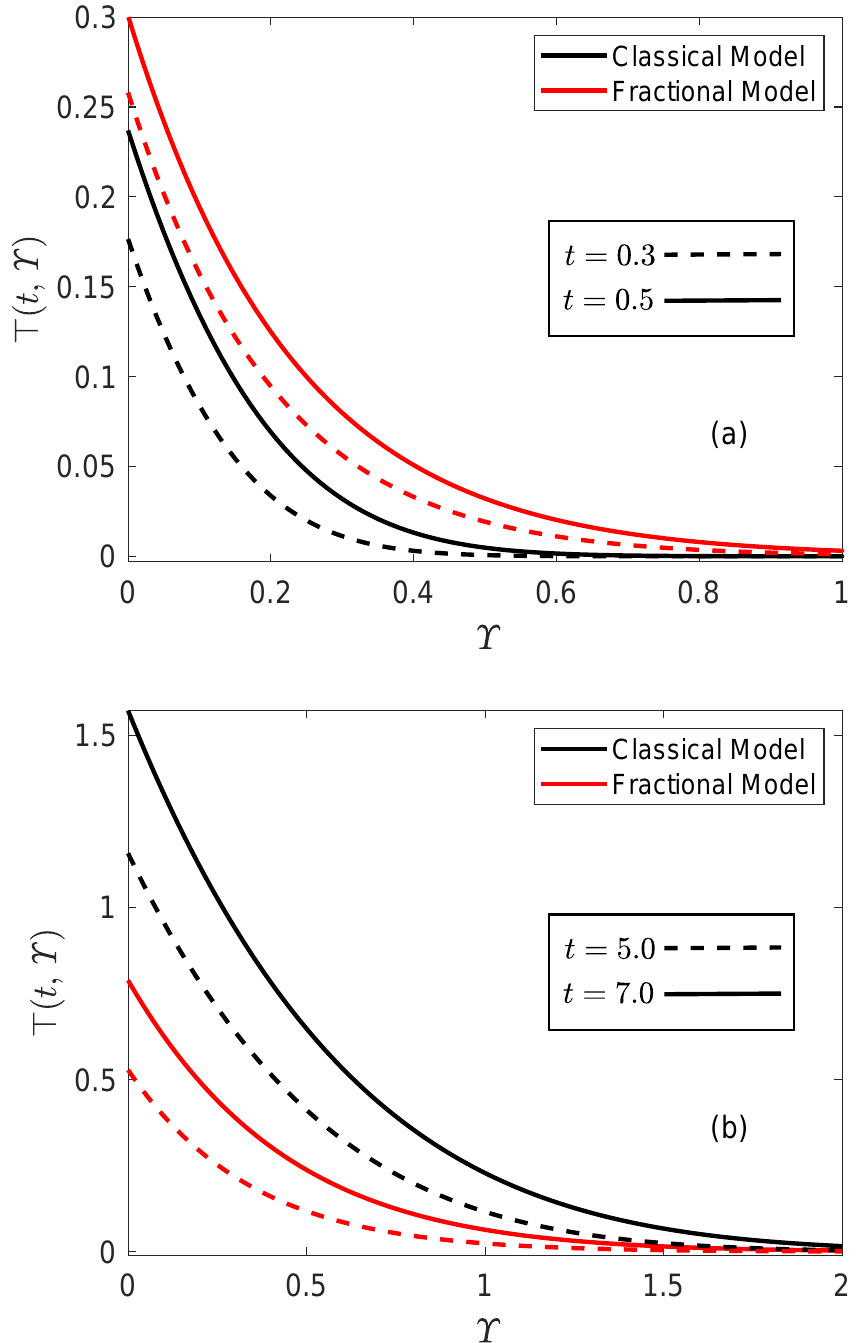
Figure 14. ( a ) Thermal profile corresponding to fractional and classical cases for smaller time inputs. ( b ) Thermal profile corresponding to fractional and classical cases for larger time